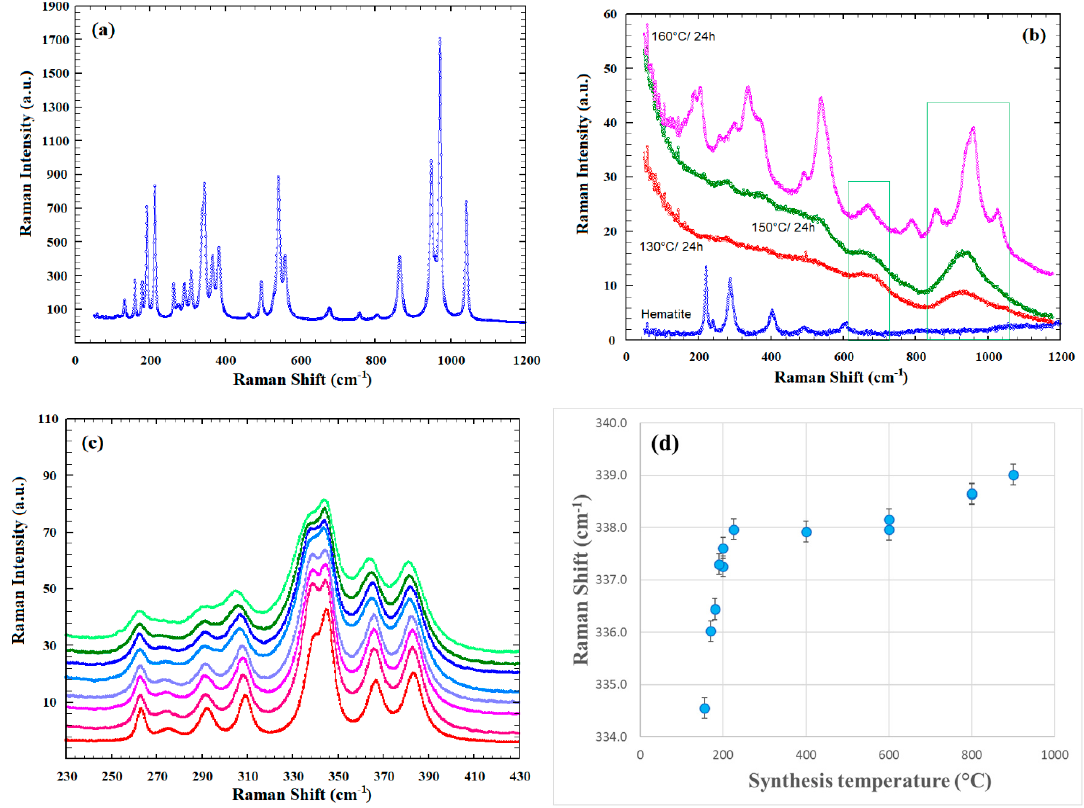
Figure 9. Selected Raman spectra of aegirine, NaFeSi 2 O 6 , synthesized at ( a ) 200 °C and sintered at 900 °C, ( b ) at 130 °C, 150 °C and 160°C in comparison with the spectrum of hematite, ( c ) gives a detail of the region R3 as a function of increasing synthesis/thermal treatment temperature and in ( d ) the shifts with temperature of the Raman mode at 337 cm –1 is shown.